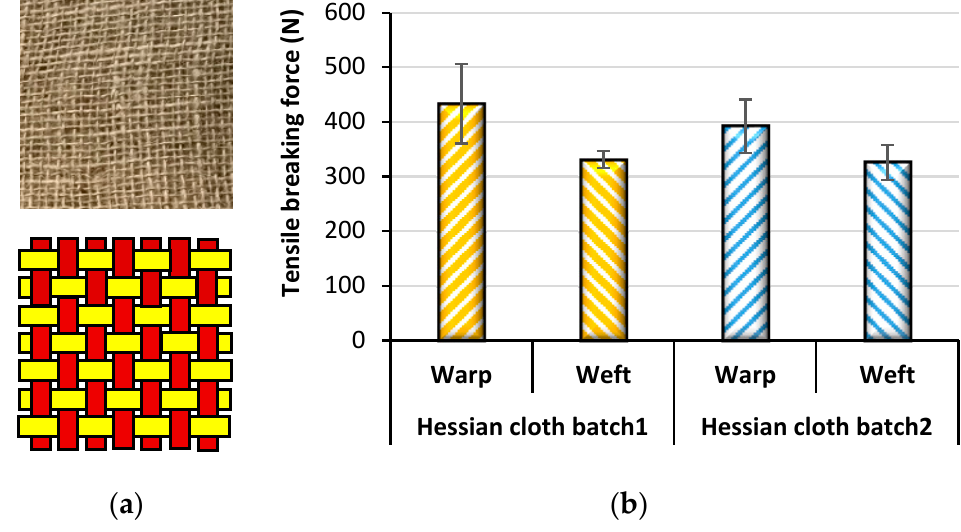
Figure 7. ( a ) Hessian Jute fabric with schematic representation of plain weave and ( b ) differences in tensile breaking forces of the jute fabrics in different directions from two different batches. Table 2. Specification of jute fabric.